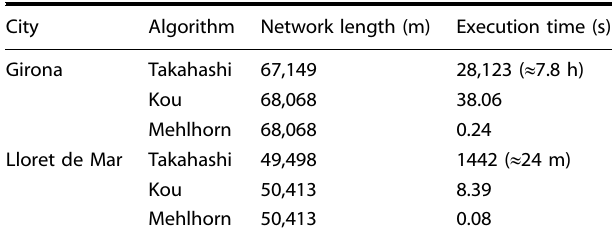
Table 2. Comparison of the decision support tool output indicators for the different routing